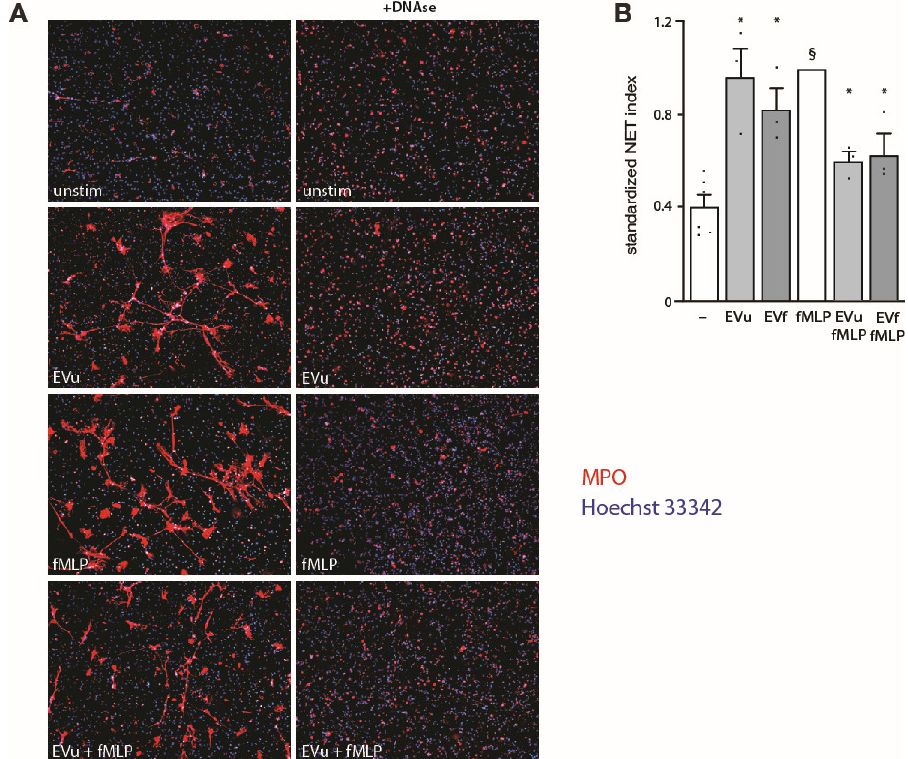
Figure 6. Effect of NDEs on NET production by autologous neutrophils. Cells were cultured for 4 h in the absence of any stimulus (“–”) or in the presence of 100 nM fMLP, NDEs from the cavitates of unstimulated neutrophils (“EVu”, at a 5:1 NDE:cell ratio), NDEs from the cavitates of fMLP-activated neutrophils (“EVf”, at a 5:1 NDE:cell ratio), or a combination thereof. NDEs were quantified as described in Figure 1 for triple-positive EVs. Samples were then further incubated in the presence or absence of 10 U/mL DNAse I for another 30 min to digest extracellular DNA. NET formation was assessed using MPO detection, as described in Methods . ( A ) A representative experiment is shown (10× magnification). ( B ) For each experimental condition, MPO fluorescence from DNAse-treated samples was subtracted from that of untreated samples so as to only quantify the NET-specific signal; these values were then standardized for the total number of nuclei. Mean ± s.e.m. of the standardized NET index from 3 independent experiments. §, p < 0.001 vs. unstimulated cells; *, p < 0.05 vs. matched condition without